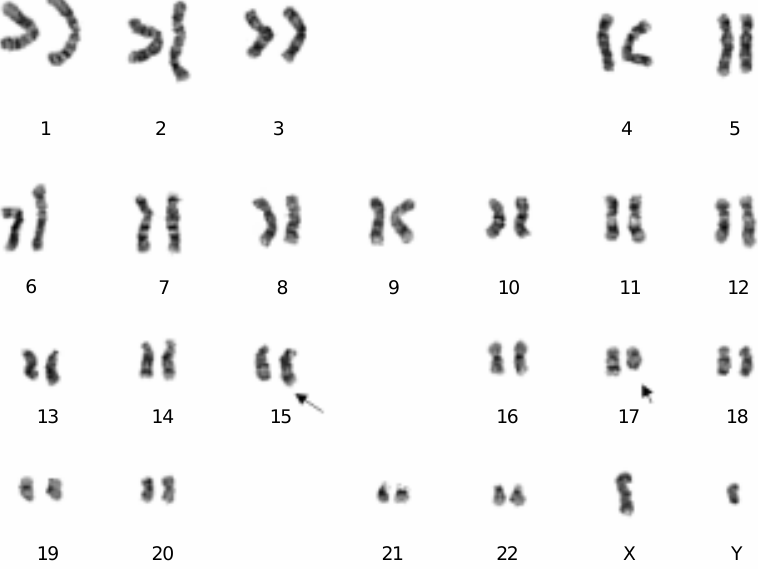
Figure 1. Karyotype showing t(15;17)(q22;q11). Arrows indicate t(15;17)